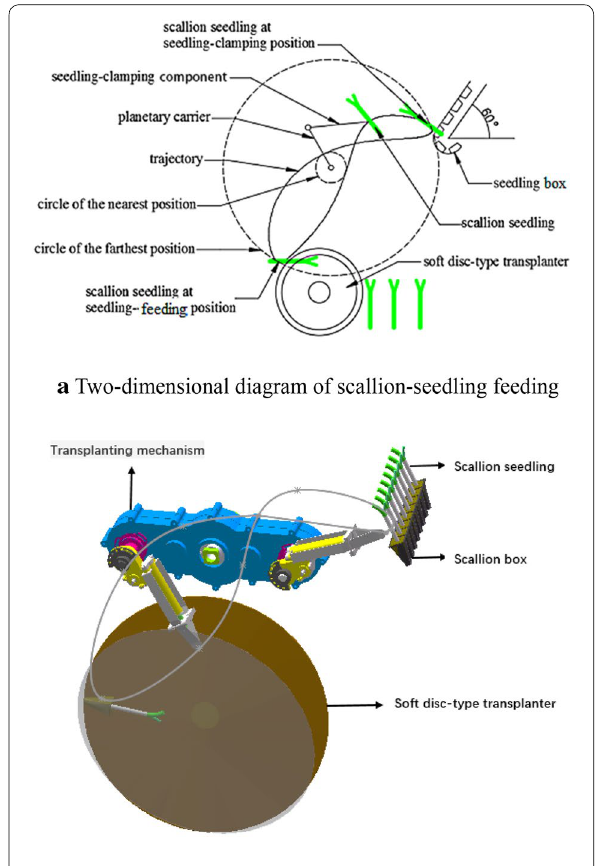
Figure 9 Trajectory design of scallion-seedling